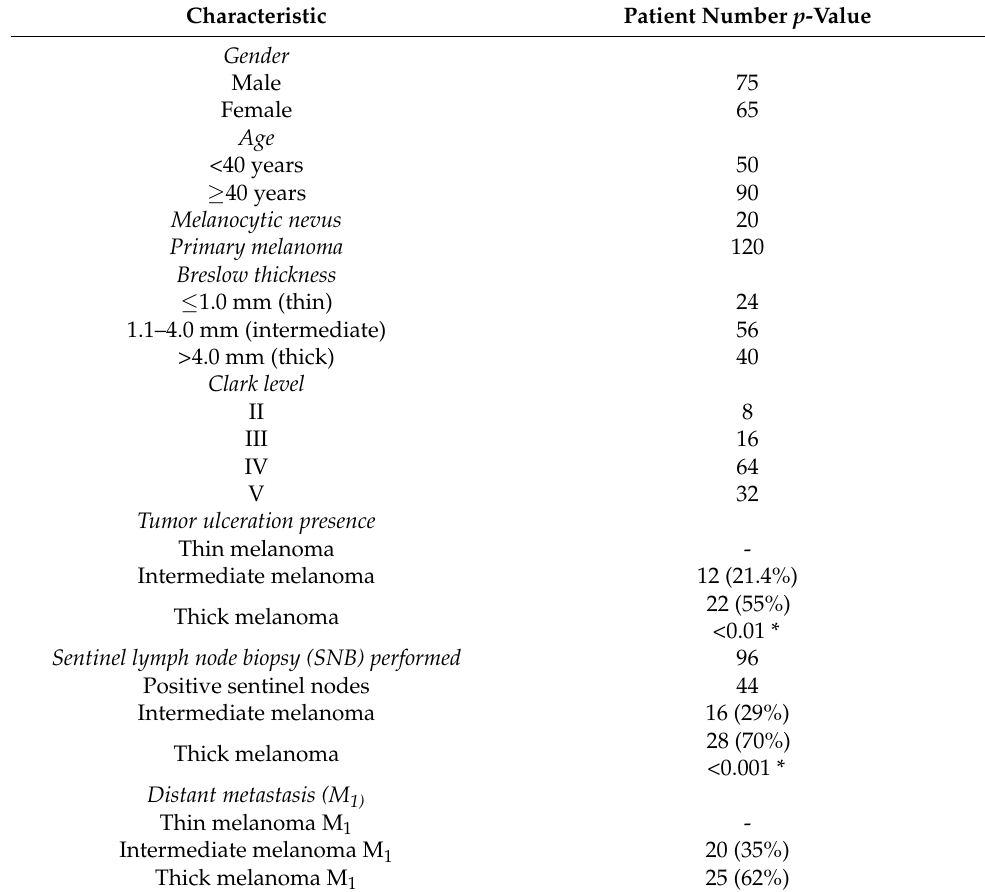
Table 1. Patient